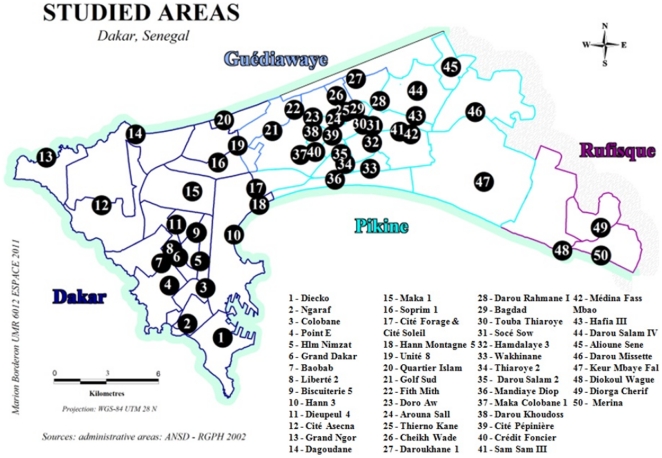
Map of the Dakar region.Black circles indicate the location of 50 study sites in 2008. Names of sites are listed below.